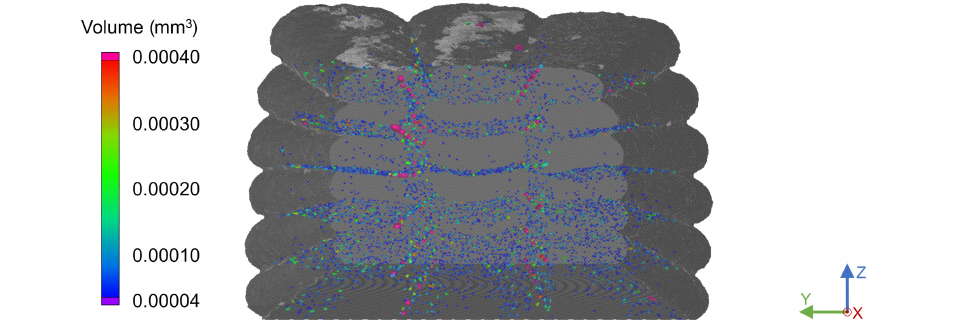
Figure 8. Front view of the porosity of a triple-strand specimen at a substrate temperature of 200 °C and a layer height of 1.0 mm with a strand distance of 2.5